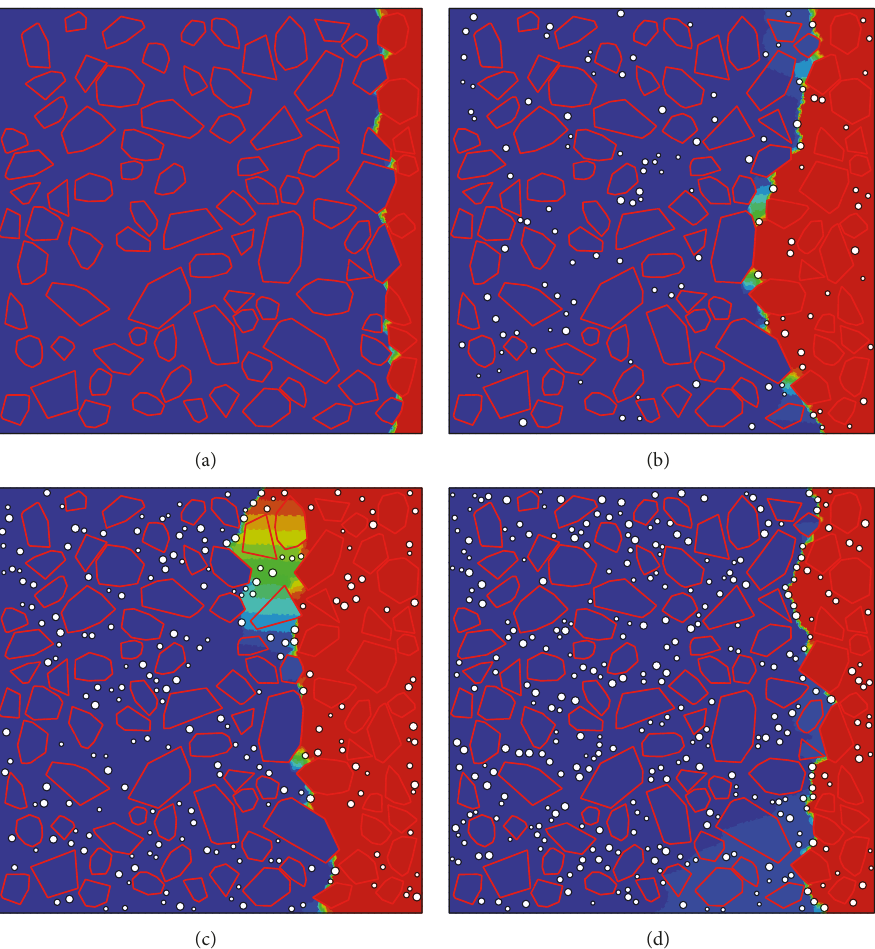
Figure 14: Fracture patterns of concrete specimens with 𝐴 𝐹 = 40 % for (a) 𝐴 V = 0 %; (b) 𝐴 V = 2 %; (c) 𝐴 V = 4 %; (d) 𝐴 V = 6